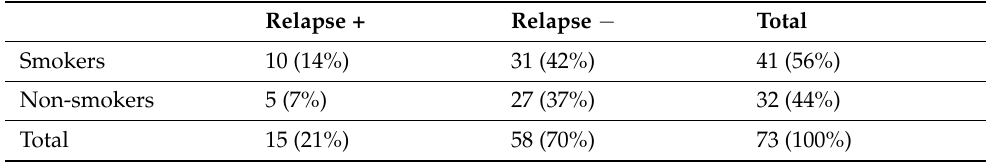
Table 7. Reintervention using Bichat fat pad flap and Buccal flap. Relapse2 + Relapse2 − Total Reintervention Bichat 0 (0%) Reintervention Buccal